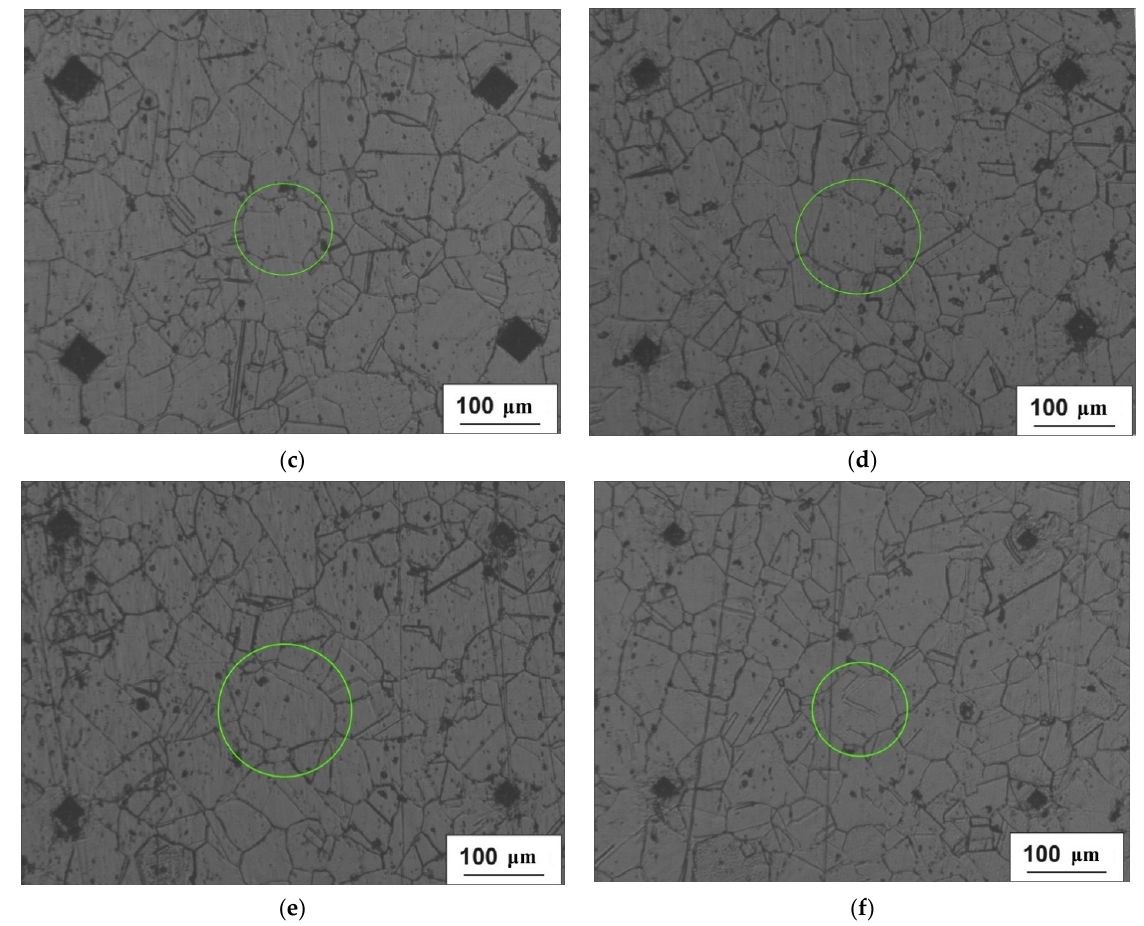
Figure 2. Sections with the same grain contours used for making the grain 3D model: ( a )—section